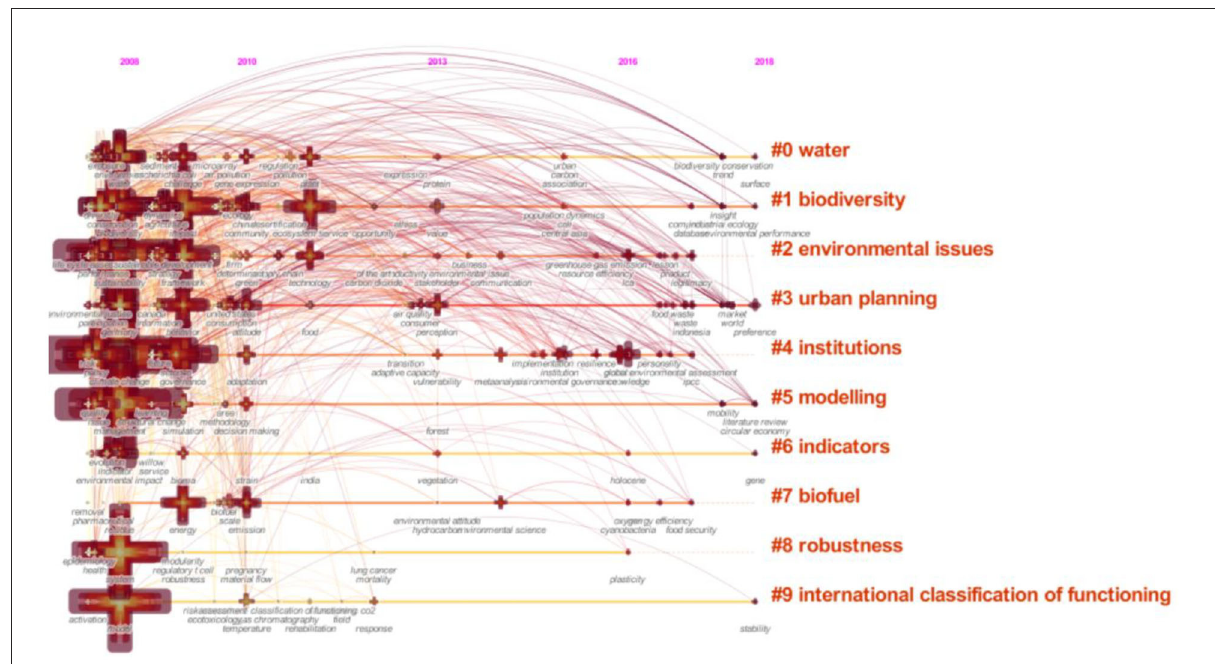
FIGURE4 A time-shift diagram of high-frequency keywords and research frontiers of environmental problems in Germany. Source: This map was drawn by the author through